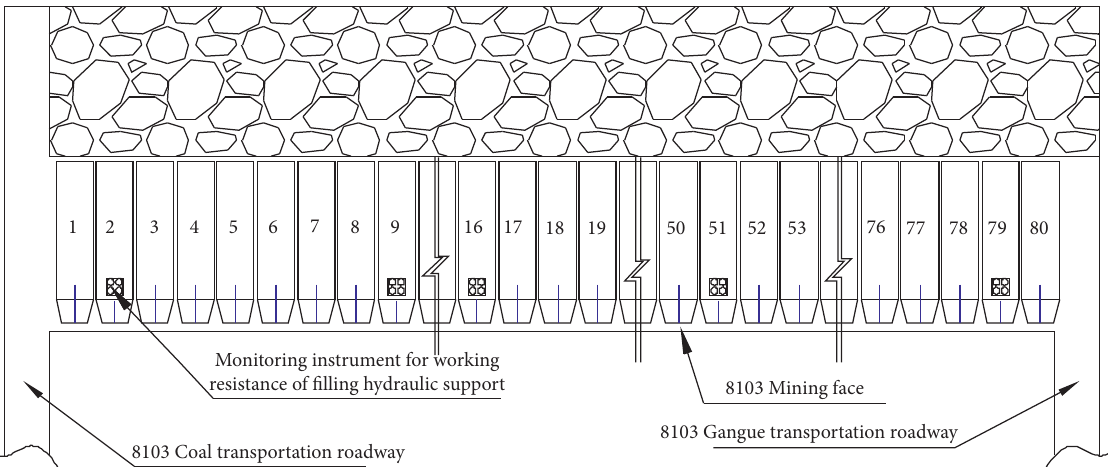
Figure 3: Layout of pressure monitoring equipment for filling hydraulic support.